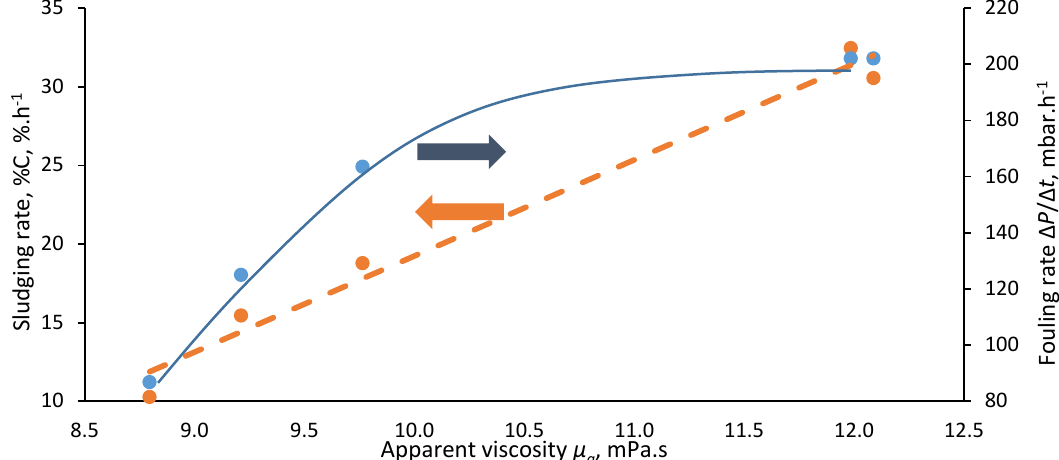
Figure 5. Sludging and fouling rates as function of apparent viscosity at a reference shear rate of 120 s − 1 .